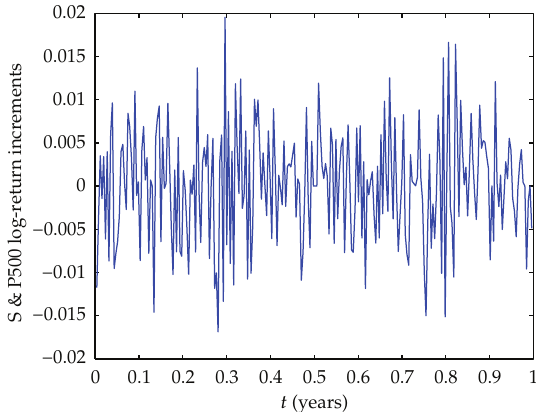
Figure 4: The S& P 500 daily log return increments (cid:2) year 2005 (cid:3) .